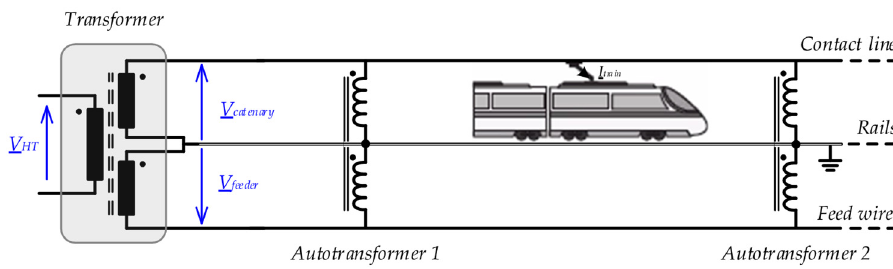
Figure 1. Principle of the “2 × 25 kV” railway electrification system.